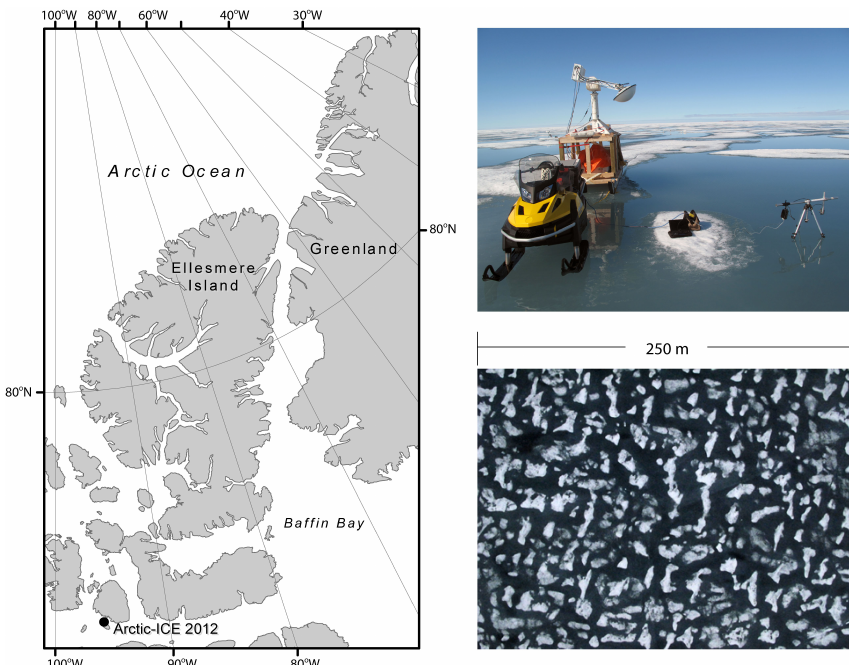
Figure 2. (Left) Map showing the location of the Arctic-ICE 2012 field study site in the central Canadian Arctic Archipelago. (Upper right) Oblique view of pond-covered level first-year sea ice with C-band frequency scatterometer (Cscat) and tripod-mounted ultrasonic sensor in the pond. In this configuration the wind is blowing from right to left across the photo. (Lower right) Aerial photo showing Nadir view of the study site on 24 June 2012, taken at 210m altitude and covering a 250m wide